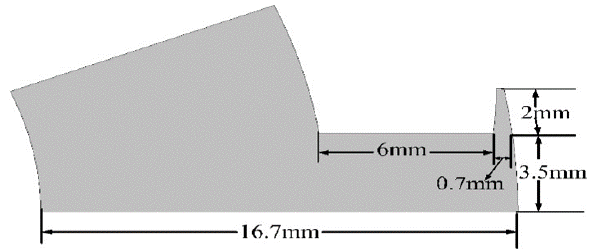
Figure 18. Flange of the rotor